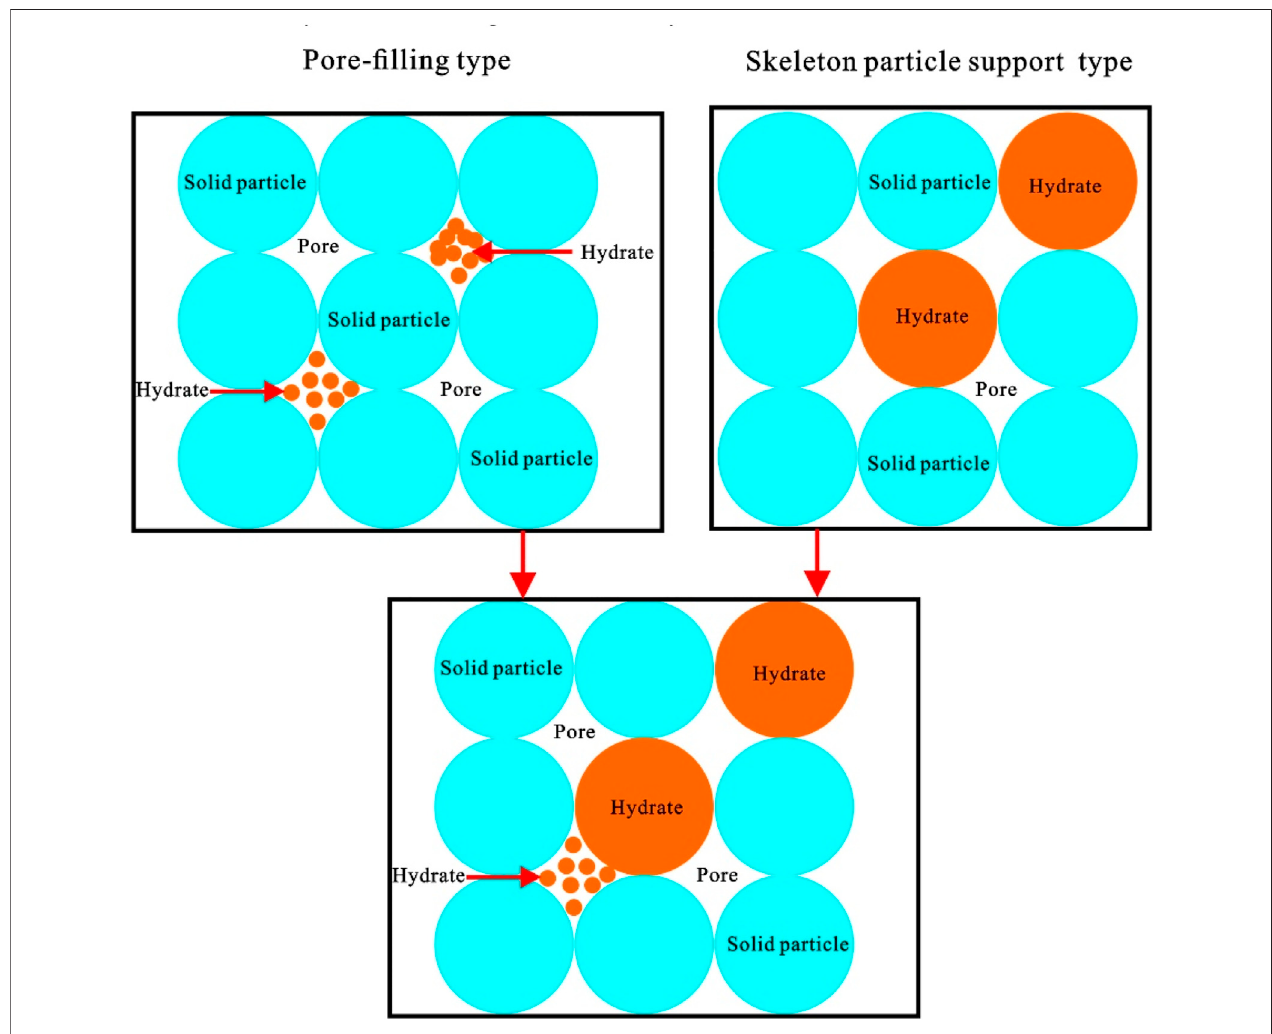
FIGURE 8 | Two-phase hydrate modeling